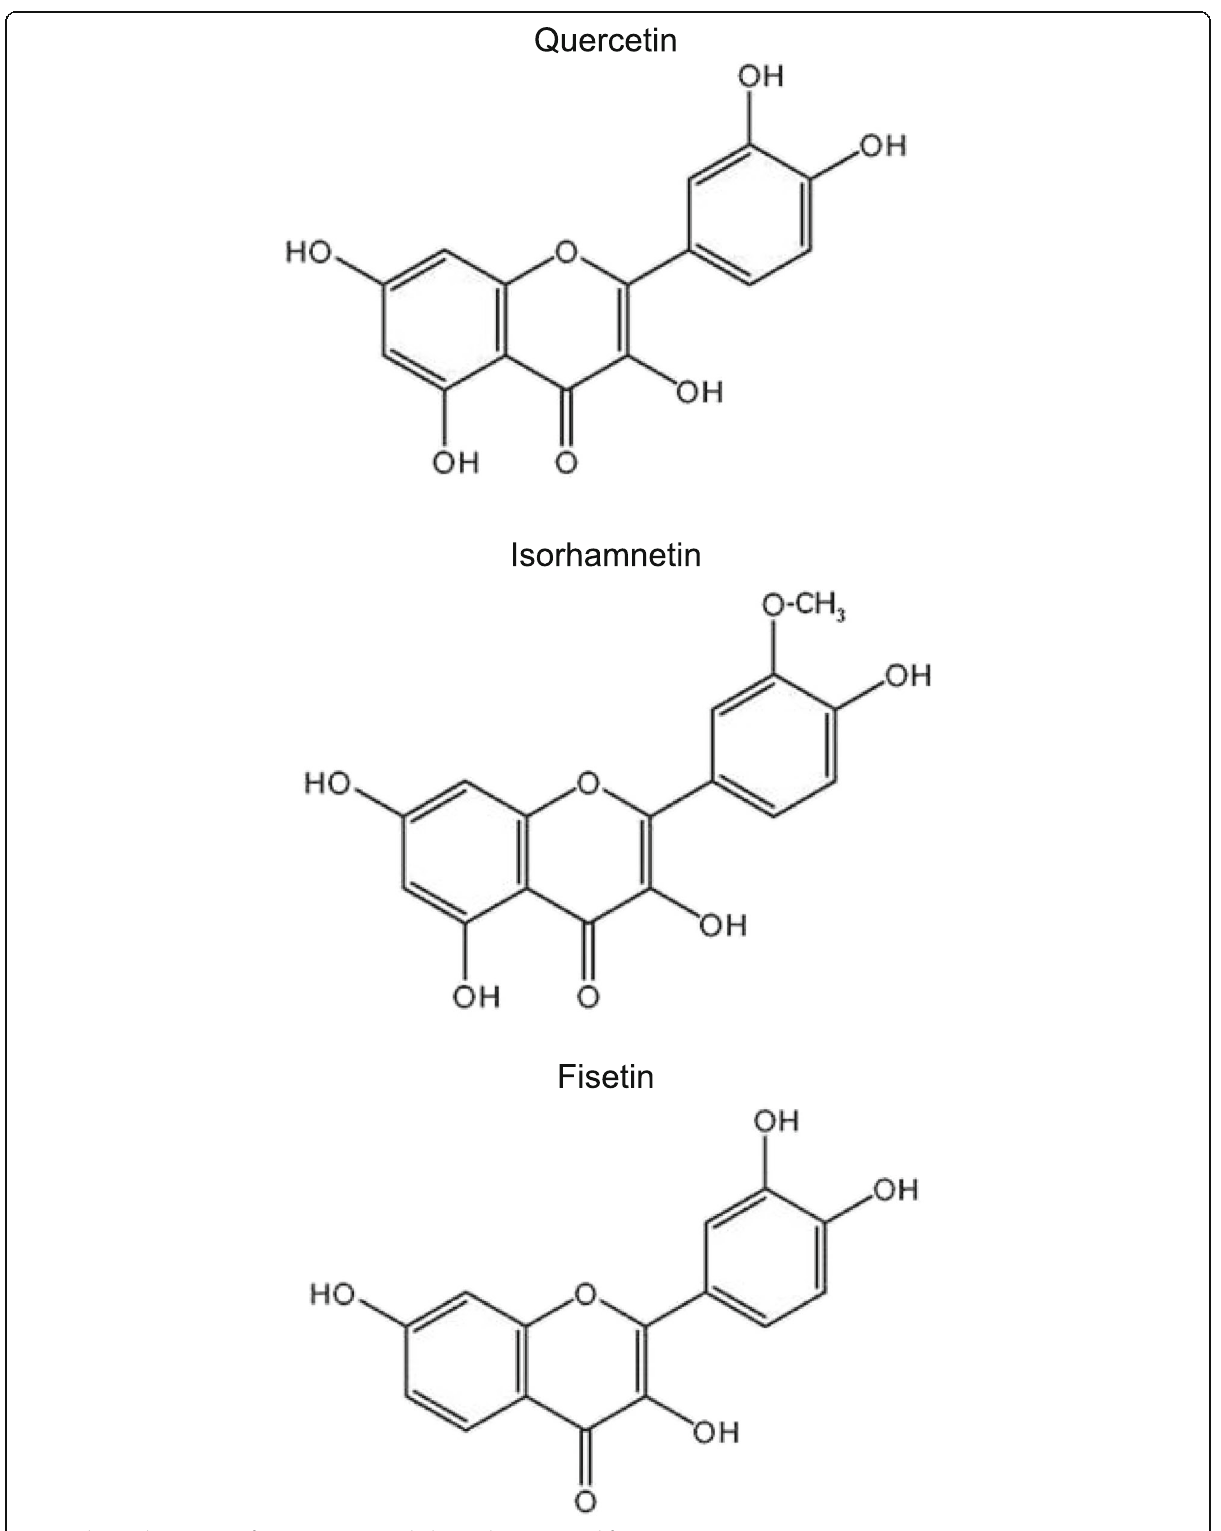
Fig. 1 Chemical structures of quercetin, its metabolite isorhamnetin and